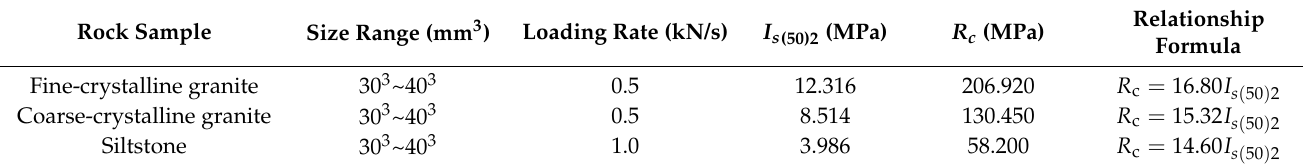
Table 10. Empirical conversion formulas for the three rock